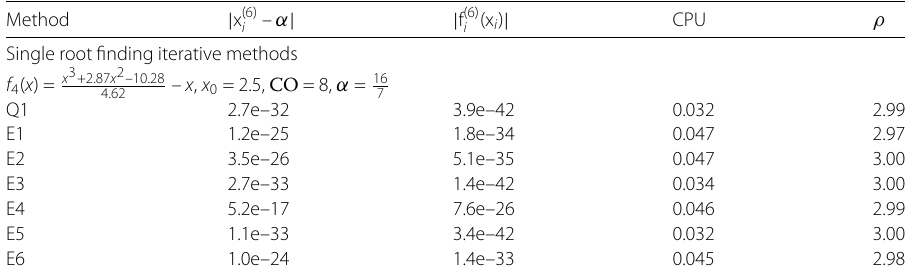
Table 2 Comparison of optimal 3rd order